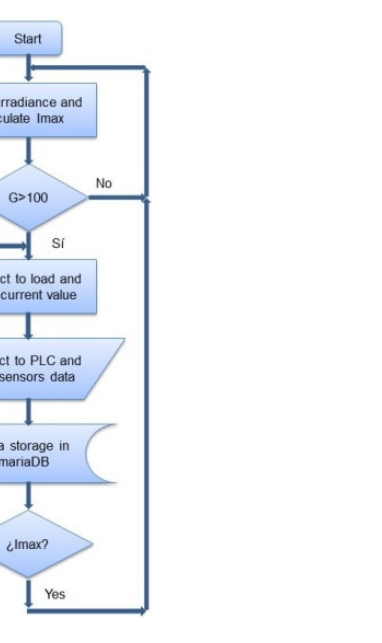
Figure 5. Database created with mariaDB for characterization of PV modules.